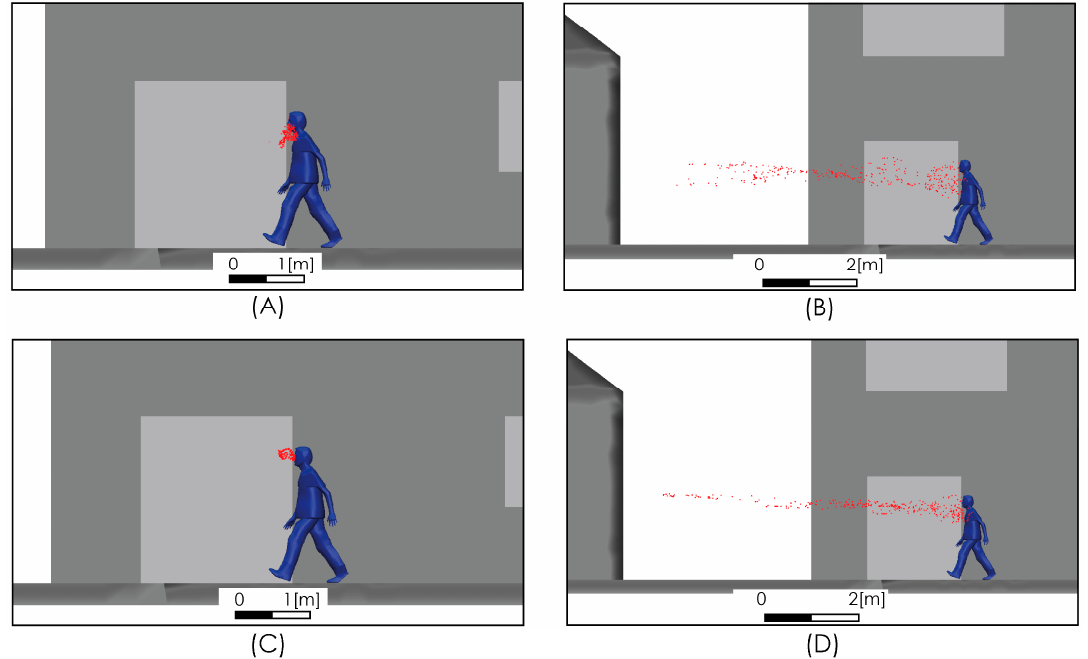
Figure 11. Aerosol propagation at t = 1 s ( A , C ) and t = 5 s ( B , D ). Moderate airflow of 2 m/s ( A , B ), and intense airflow of 4 m/s ( C , D ).